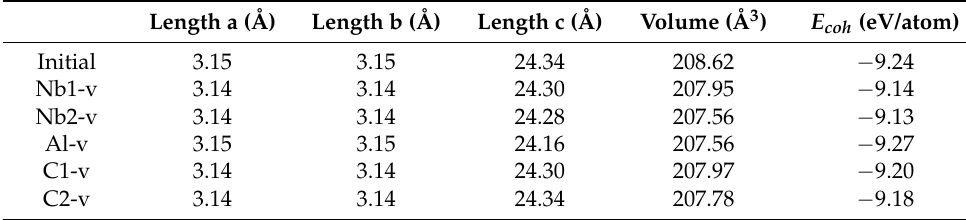
Table 3. Cohesive energies for Nb 4 AlC 3 with different vacancies.